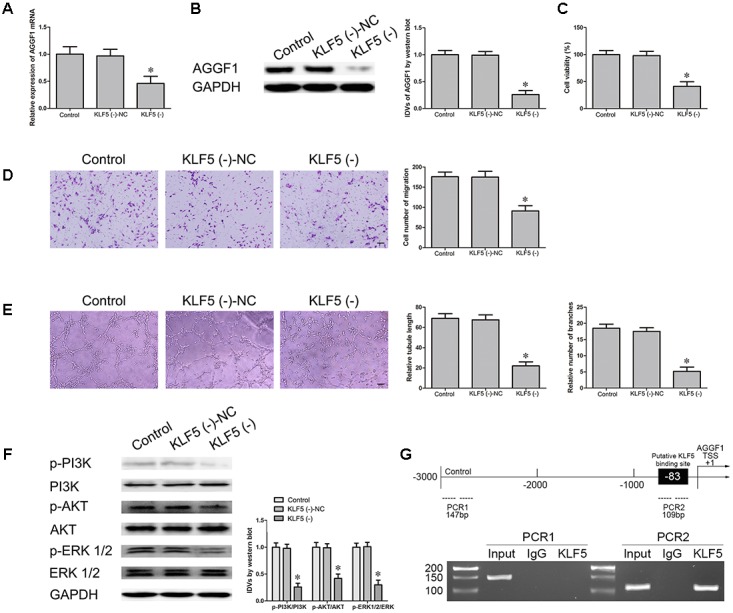
KLF5 exerted oncogenic role and could modulate AGGF1 expression by binding to its promoter region in GECs. (A,B) Effect of KLF5 knockdown on the expression of AGGF1 mRNA and AGGF1 protein level. (C) CCK-8 assay was applied to evaluate the effect of KLF5 knockdown on GECs proliferation. (D) Effect of KLF5 knockdown on quantification number of GECs migration. (E) Effect of KLF5 knockdown on GECs tube formation. Data are presented as mean ± SD. (F) Western blot analysis of p-PI3K, PI3K, p-AKT, AKT, p-ERK1/2, and ERK1/2 regulated by KLF5 in GECs, using GAPDH as endogenous control. Data are presented as mean ± SD. (n = 5, each group), ∗P < 0.05 vs. KLF5 (-)-NC group. (G) KLF5 bound to the promoter region of AGGF1 in GECs. Putative KLF5 binding sites are indicated. Immunoprecipitated DNA was amplified by PCR. Normal rabbit IgG was used as a negative control. Scale bars represent 30 μm.